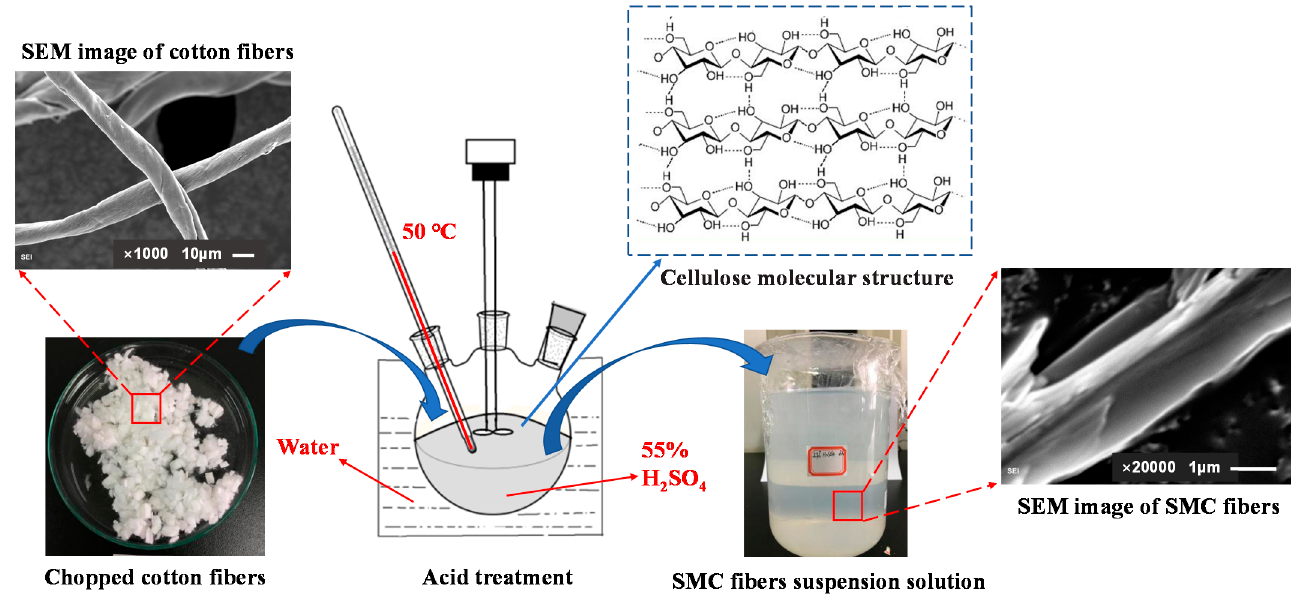
Figure 2. Apparatus for preparation of SMC fibers.